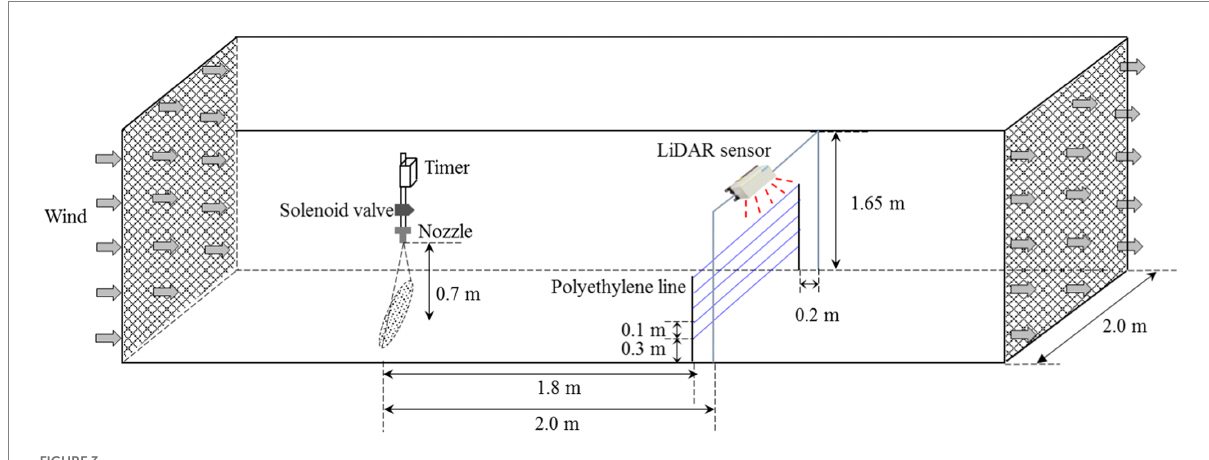
FIGURE 3 Construction of a test platform for measuring droplet drift in the wind tunnel.